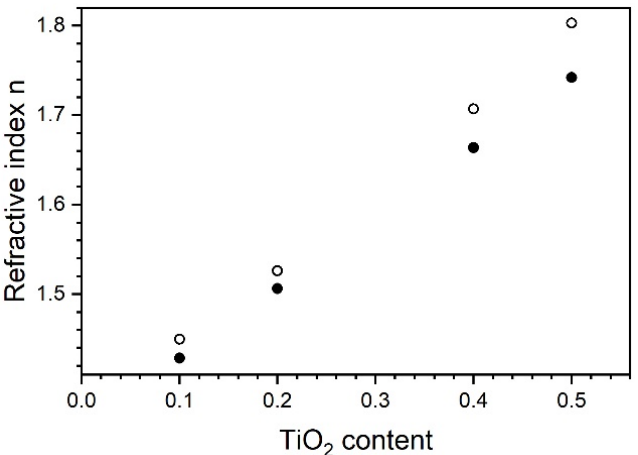
9 of 12 Figure 8. Thickness variation as a function of decreasing temperature for samples 50%—(a), 40%— (b), 20%—(c), 10%—(d) calculated using Sellmeier model in wavelength range between 1688 nm and 350 nm and data measured after completion of heating/cooling procedures. Given the above fact, the refractive index dispersion in the transparent window (1688